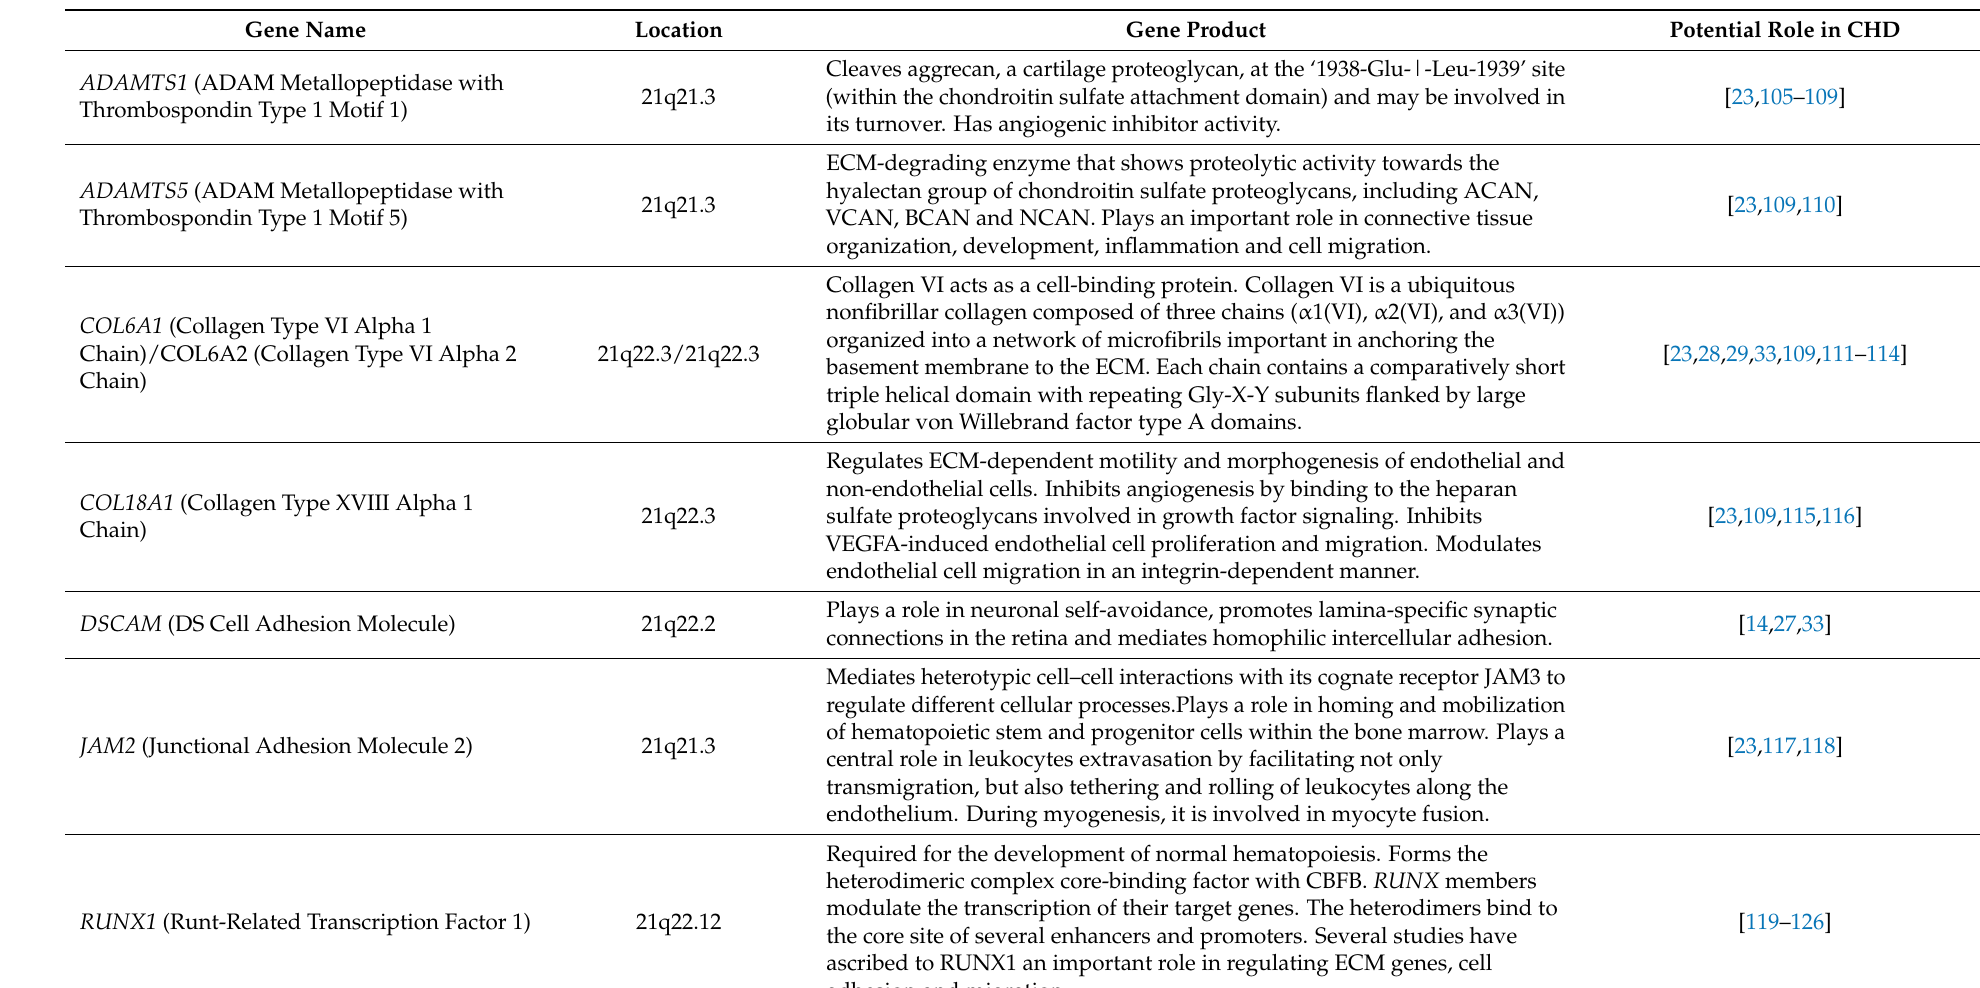
Table 1. ECM-related genes dysregulated in DS, possibly involved in the occurrence of